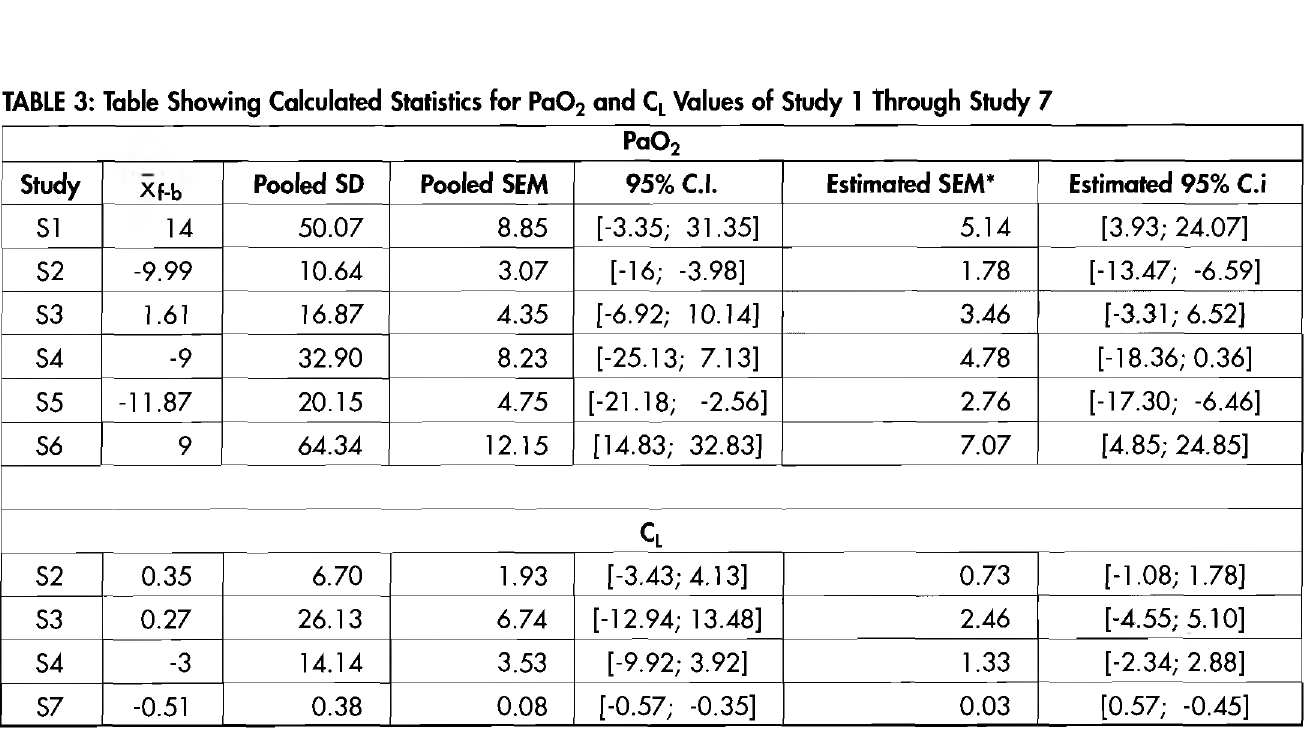
TABLE 3: Table Showing Calculated Statistics for Pa02 and CL Values of Study 1 Through Study 7